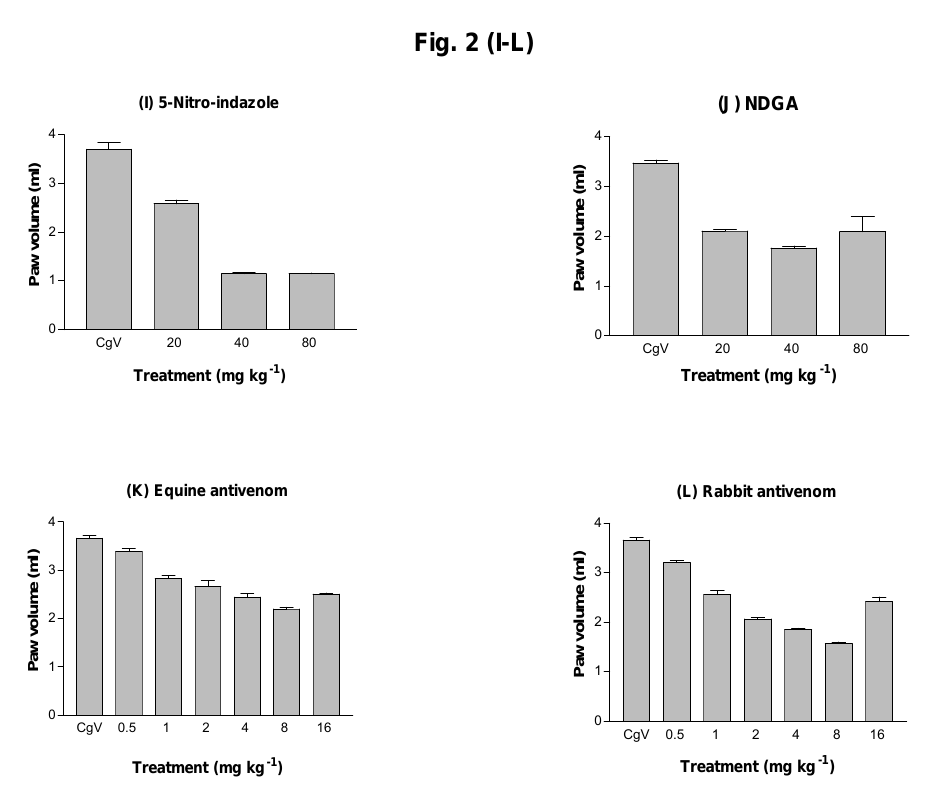
Figure 2: Inhibitory effects of several drugs and antivenoms. All of them were titrated against 120 µg/paw (0.49 mg/kg) Cerastes gasperettii venom to detect their minimum effective dose. Serial double dilutions of each drug or antivenom were according to the following ranges: (A) mepyramine, 3-24 mg/kg, 15 min before venom; (C) cyproheptadine, 1.5-24 mg/kg, 15 min before venom; (D) dexamethasone, 0.25-2 mg/kg, 2 h before venom; (B) diclofenac, 5-80 mg/kg, 30 min before venom; (E) aprotinin, 1x10 3 -4x10 3 KIU/kg, 30 min before venom; (F) dipyridamole, 30-120 mg/kg, 30 min before venom; (G) N ω -nitro-L-arginine, 25-200 mg/kg, 30 min before venom; (H) quinacrine, 25-200 mg/kg, 30 min before venom; (I) 5-Nitroindazole, 20-80 mg/kg, 30 min before venom; (J) nordihydroguaiaretic acid (NDGA), 20-80 mg/kg, 30 min before venom. All drugs were intraperitoneally administered to rats. Equine and rabbit antivenoms (0.5-16 mg/kg) were administered intravenously (results not shown) or locally (mixed with 120 µg CgV and incubated for 30 min at 37°C). A positive control group received heated 120 µ g/paw (0.49 mg/kg) CgV alone in the same experimental conditions. Each column represents mean ± SEM of six